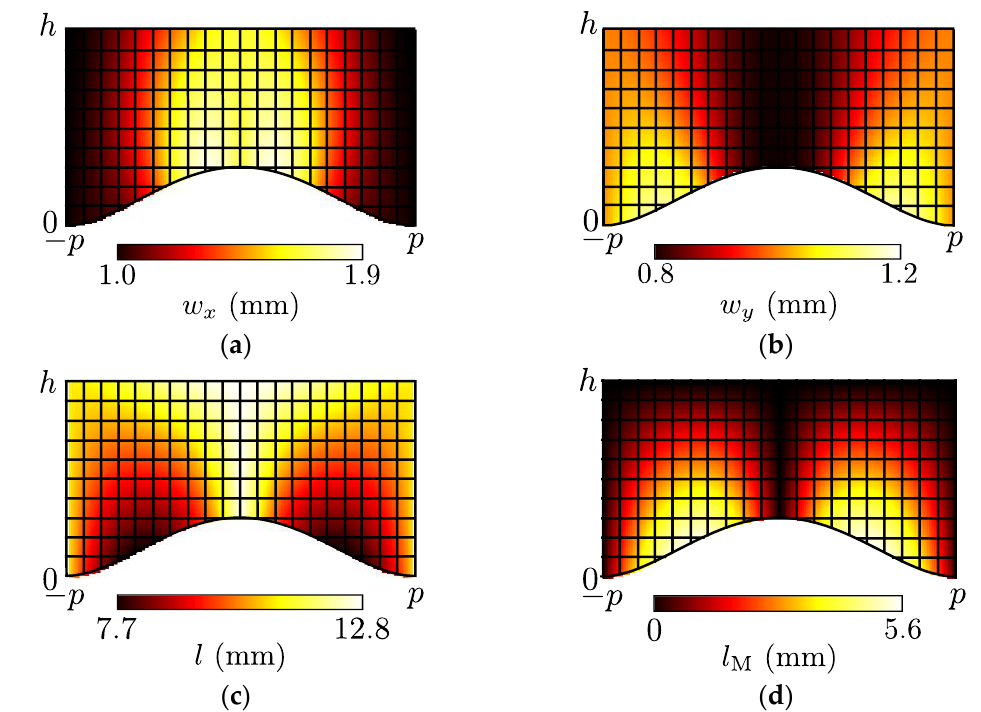
Figure 8. Calculated results of the waveguide widths and lengths for the acoustic carpet cloak ( w M =